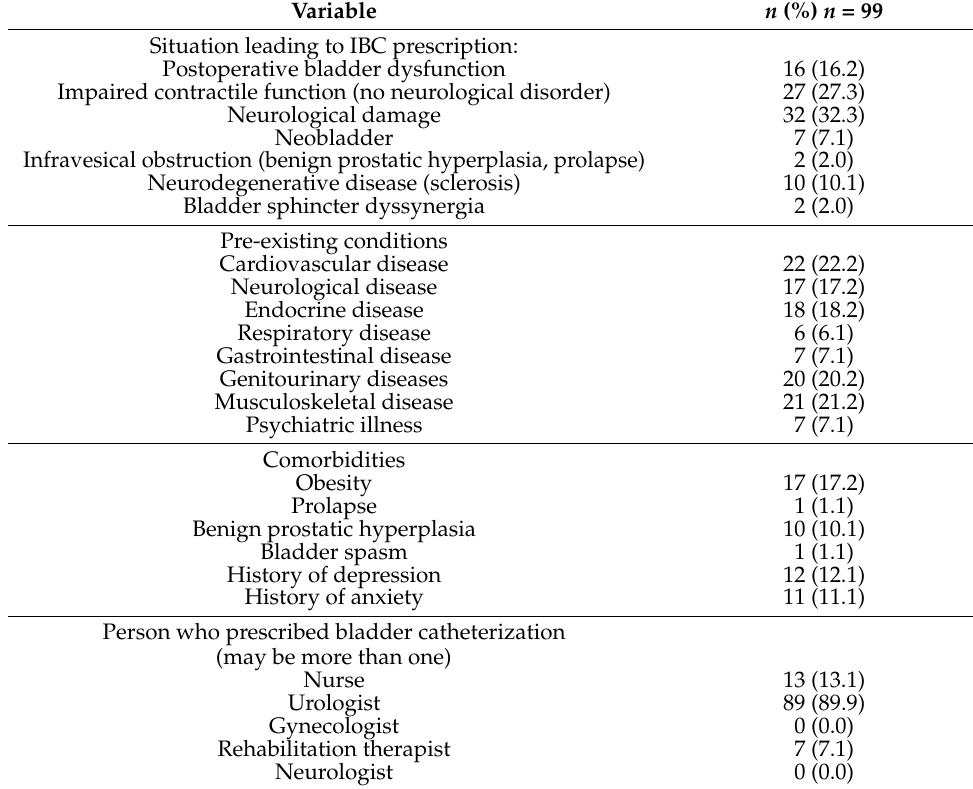
Table 2. Clinical characteristics of patients under